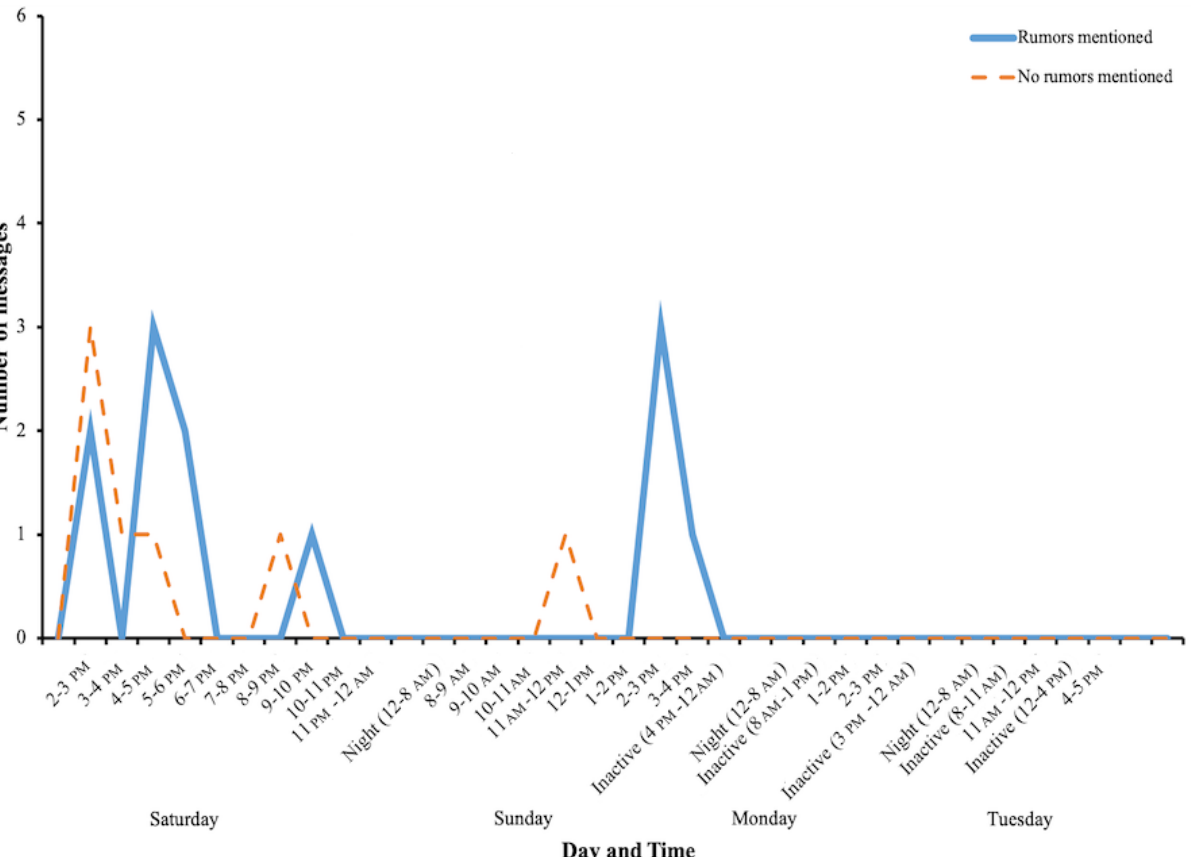
Figure 5. Number and time distribution of messages elaborating the group topic (influence of technology on health) that contained a rumor versus equivalent messages that did not contain a